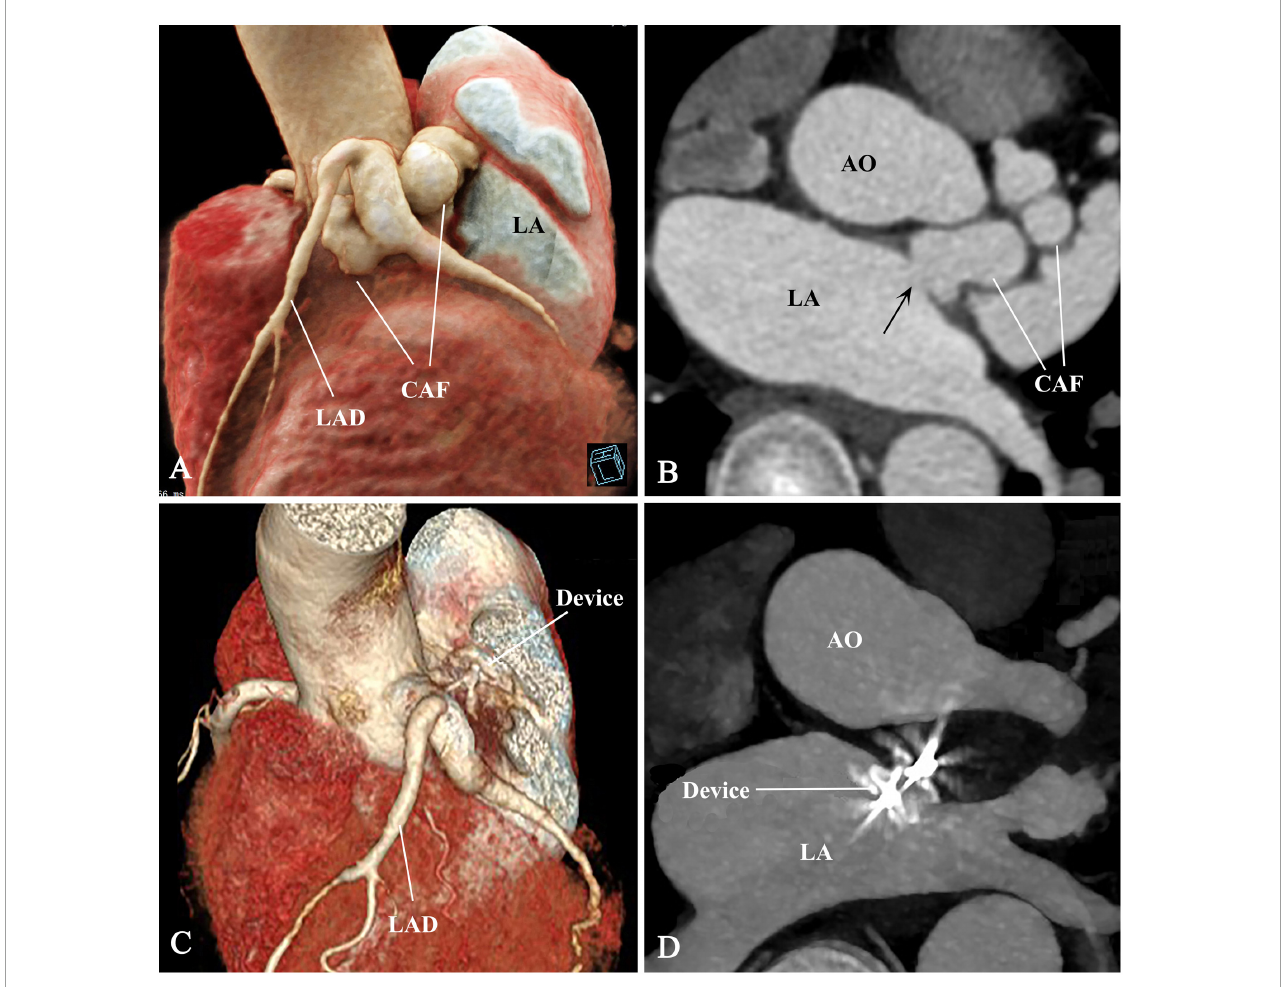
FIGURE3 Pre- and post-procedural comparison of CAF. (A–D) The CAF disappeared and thrombogenesis occurred from distal to proximal segment of the CAF. CAF, coronary artery fistula; AO, ascending aorta; LAD, left anterior descending branch; LA, left atrium; arrow, fistulous drainage